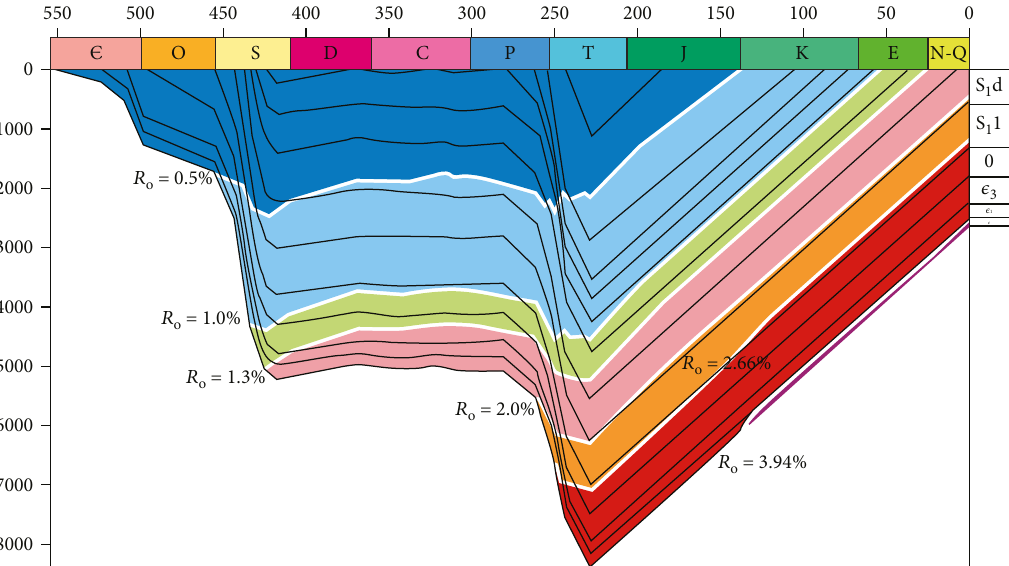
Figure 11: The burial history and the thermal evolution history of Jiangye-1 in Xiuwu Basin. See Figure 1 for the well location (modi fi ed from Li et al. [45]).